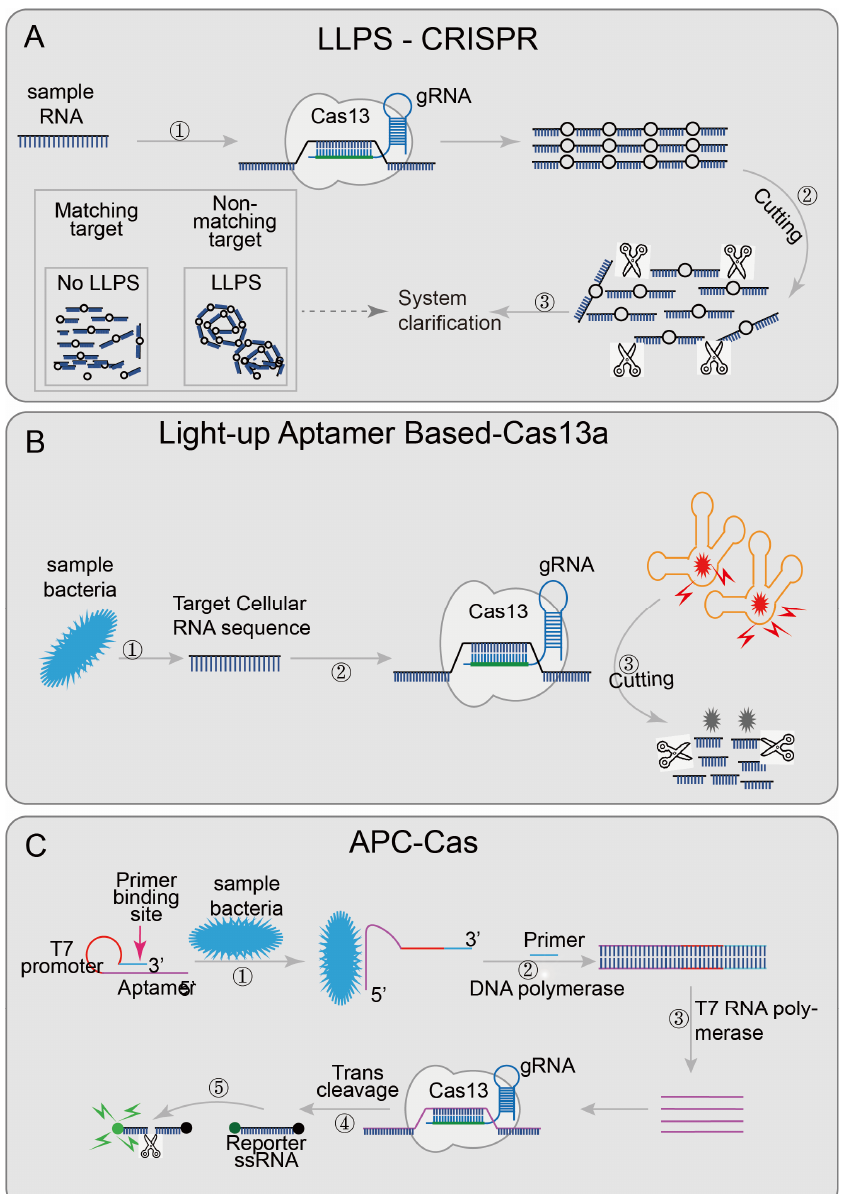
Figure 5. Applications of CRISPR/Cas13 and CRISPR/Cas14 technology: ( A ) LLPS-CRISPR, com- bined with the collateral cleavage activity of Cas12a/Cas13a, cleaves long-chain into short-chain nucleotides when the target sequence is present; then the solution will become clear afterwards; ( B ) Light-up aptamer-based-Cas13a introduces a new light-up RNA aptamer broccoli/DFHBI-1T complex; when the target sequence is present, Cas13a digests the aptamer broccoli, and the high-fluorescence bound-state DFHBI-1T becomes the low-fluorescence free state; ( C ) APC-Cas's aptamer domain will specifically recognize and bind to the target pathogen, so that AP expands from a hairpin-like inactive structure and transforms into an active structure; the primer domain can be combined with the primer, and then, with the participation of DNA polymerase, AP is used as the template chain to generate dsDNA, which replaces the target pathogen and realizes the first amplification; then the T7 promoter domain is amplified by T7 RNA polymerase to achieve the second step of amplification; subsequently, the Cas13a/crRNA complex recognizes the ssRNA produced by the second step and non-specifically cleaves a large number of surrounding RNA gene reporter probes, achieving the third step of amplification, finally generating a fluorescent signal.